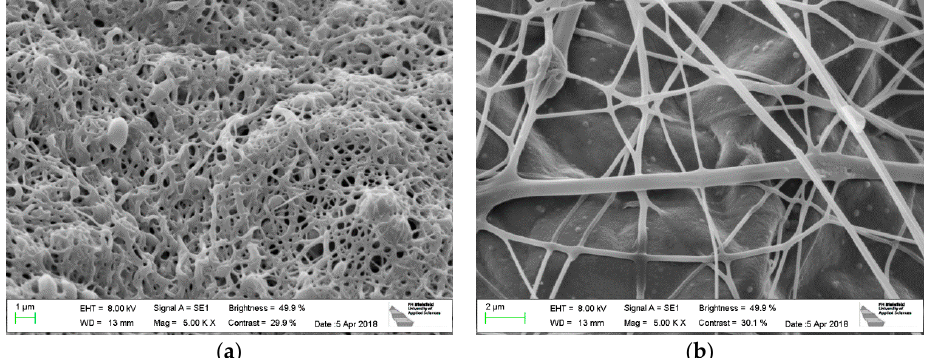
Figure 7. PAN nanofiber mats after carbonization at 800 °C: ( a ) electrospun on PP (substrate separated before stabilization); ( b ) electrospun on aluminum foil (substrate not removed before stabilization).